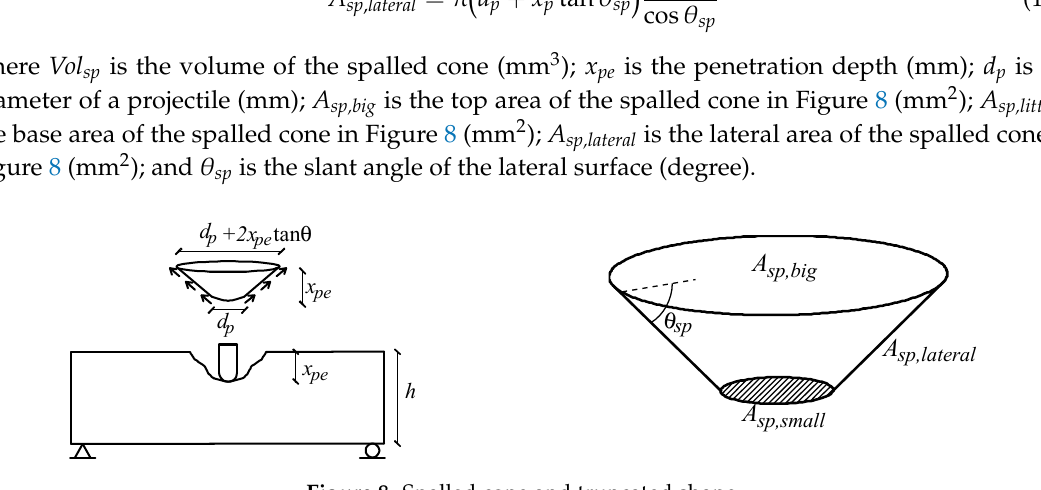
Figure 8. Spalled cone and truncated shape.